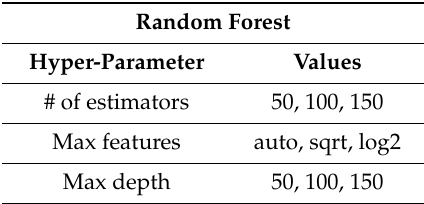
Table 11. Hyper-parameters of Random Forest.